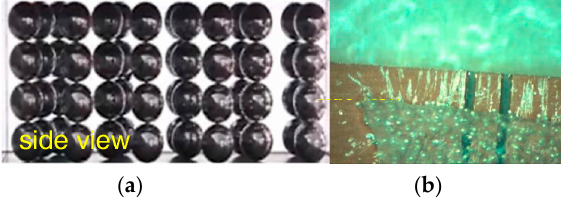
Figure 1. Anisotropic conducting polymer (ACP) with BallWire ® technology (Adapted with permission from[5], Paricon Technologies Inc., 2017) ( a ) silver-plated nickel spheres stapled to chains ( b ) penetration of the oxide layer.